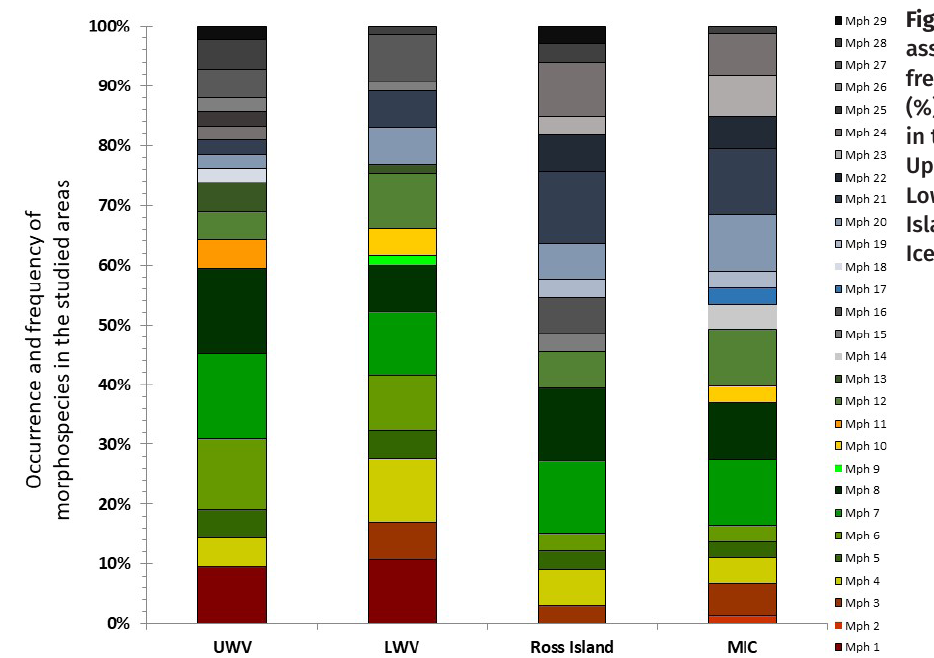
Figure 5. Cyanobacterial assemblages and frequency of occurrence (%) of each morphospecie in the studied areas. UWV = Upper Wright Valley; LWV= Low Wright Valley; Ross Island and MIS = McMurdo Ice Self. Mph =